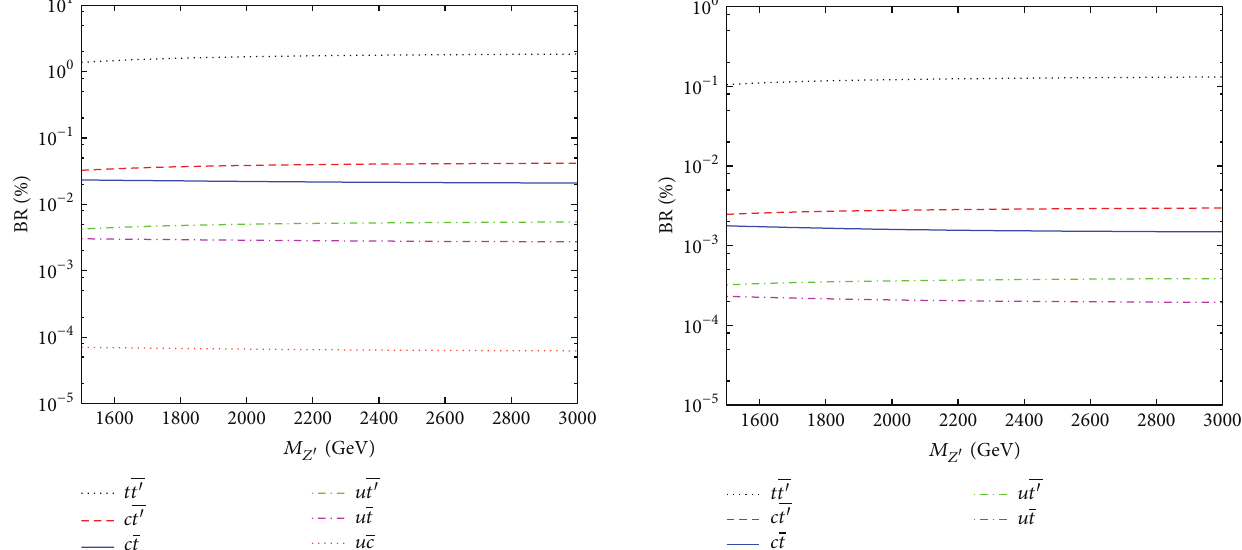
boson for FCNC couplings to different flavors of up-sector quarks within the 𝑍 󸀠 LP model. Here the mass of 𝑡 󸀠 quark is 700 GeV and the FCNC parameter 𝑥 = 0.1 .